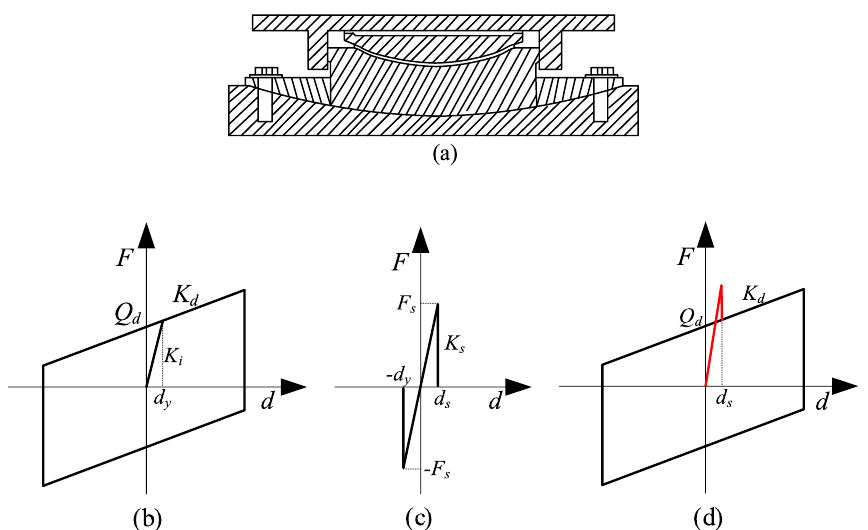
Fig. 1 Structure and force–displacement behavior of the FPB: a structure of FPB; b FPB model; c shear pin model; and d force–displacement behavior of FPB with the shear pin